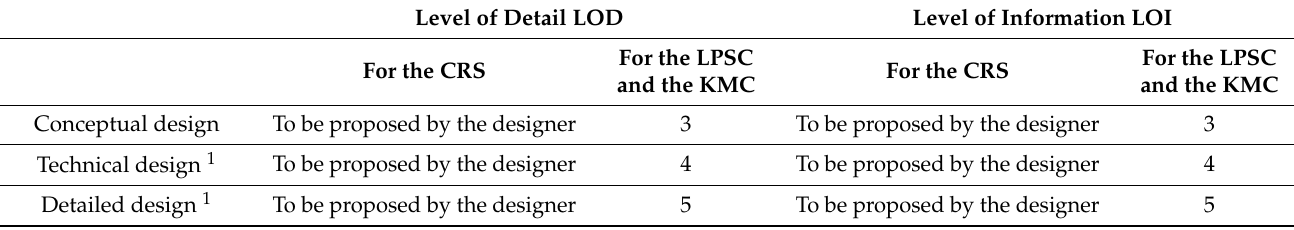
Table 3. Levels of Detail (LOD) and Levels of Information (LOI) for the Cogiteon Lesser Poland Science Center (LPSC), the Krakow Music Center (KMC) and the Copernican Revolution Studio (CRS). Original work based on EIRs for the LPSC, the KMC and the